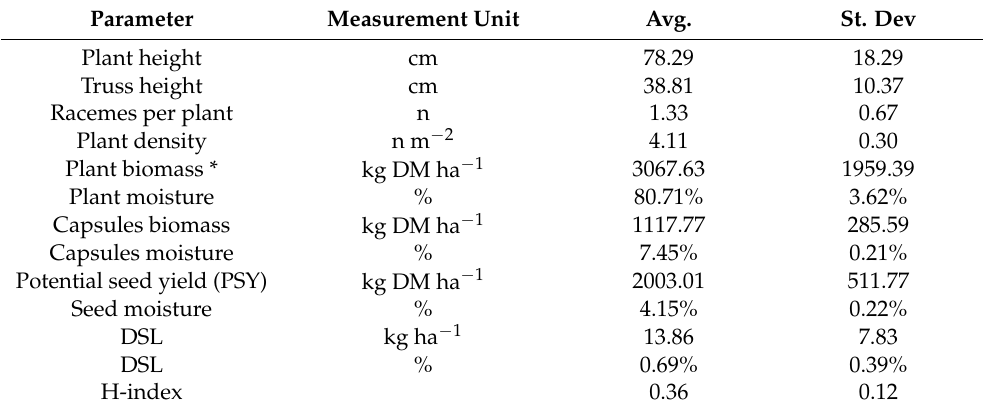
Table 1. Morphologic traits of dwarf Kaiima hybrid C1012, potential seed yield, and natural dehis- cence of